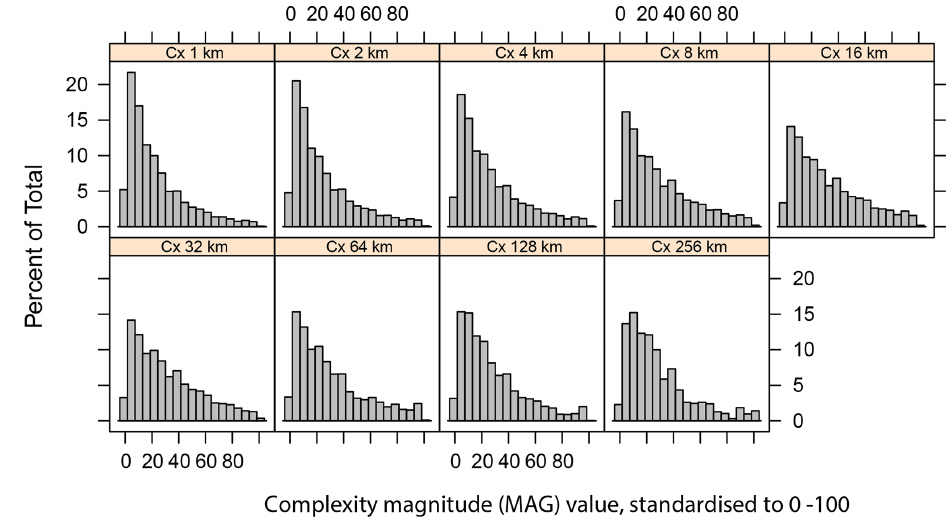
Figure 3. Histograms of each MAG variable at each length scale, showing a strong right skew for every length